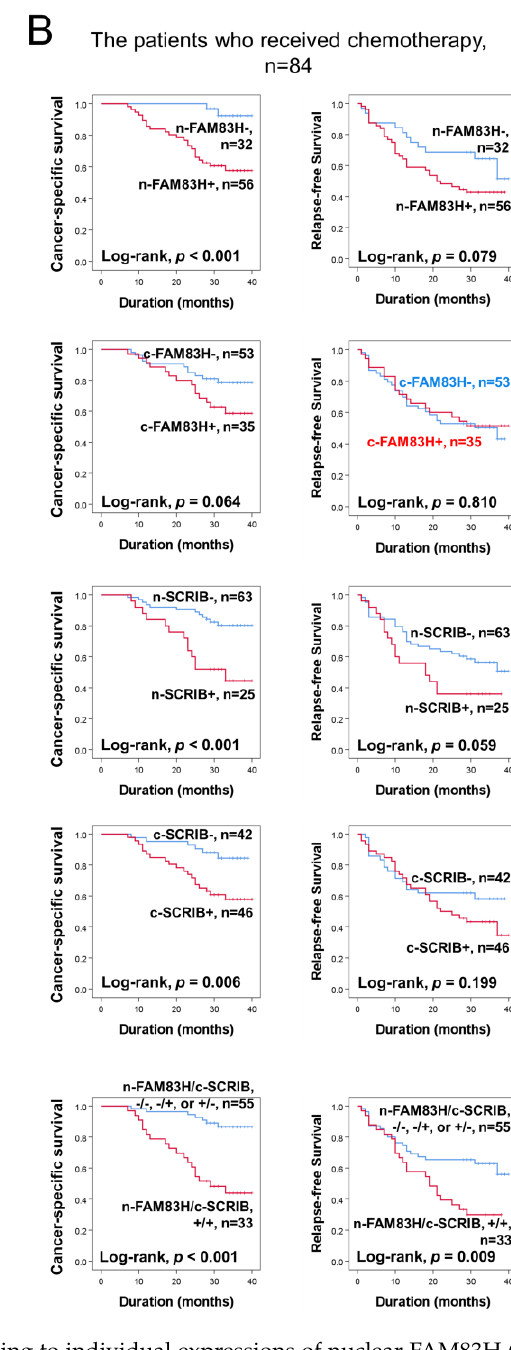
Figure 4. Survival analysis according to individual expressions of nuclear FAM83H (n-FAM83H), cytoplasmic FAM83H (c-FAM83H), nuclear SCRIB (n-SCRIB), cytoplasmic FAM83H (c-SCRIB), and co-expression patterns of nuclear FAM83H and cytoplasmic SCRIB (n-FAM83H/c-SCRIB) in the subgroups of CRC patients who received or did not receive adjuvant chemotherapy. ( A ) Kaplan – Meier survival curves in the 138 patients who did not receive chemotherapy. ( B ) Kaplan – Meier survival curves in the 84 patients who received adjuvant chemotherapy.